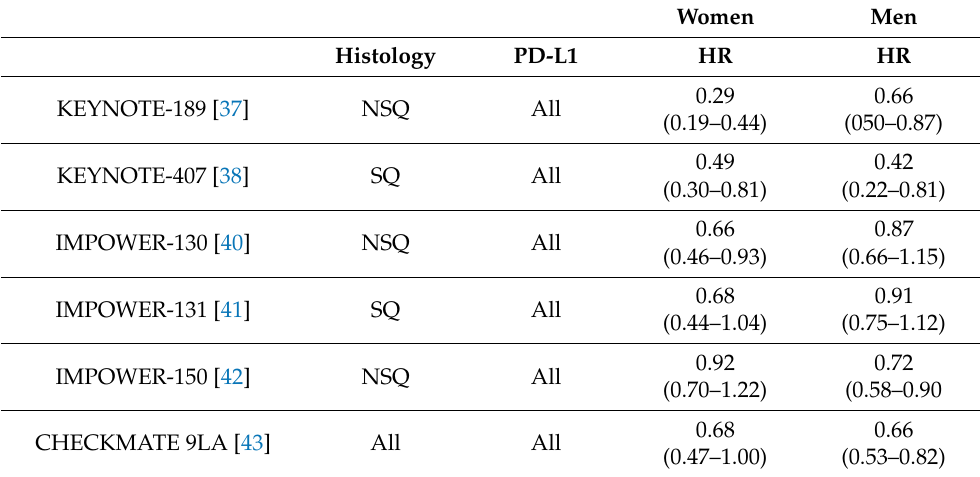
Table 2. List of phase 3 trials of approved immunotherapy schemes containing chemotherapy in first-line treatment of non-small cell lung